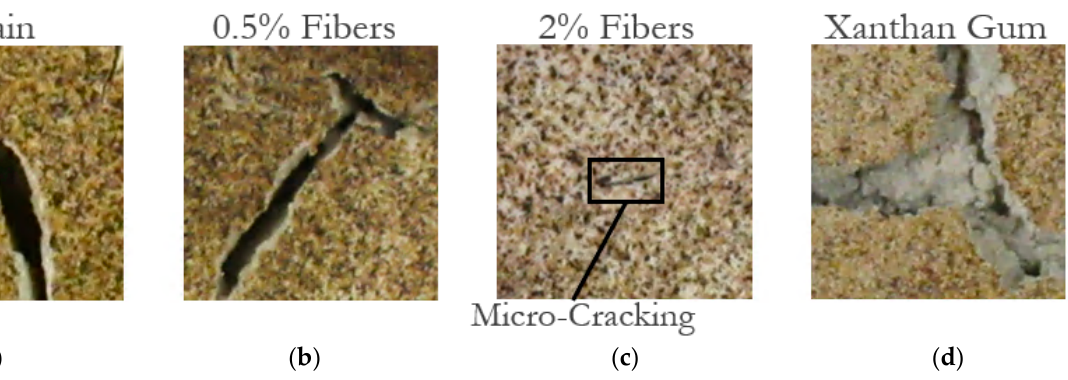
Figure 5. Comparison of cracks in kaolinite soil in ( a ) untreated samples, ( b ) samples aided with 0.5% fibers, ( c ) samples aided with 2% fibers, and ( d ) xanthan-gum-aided samples.